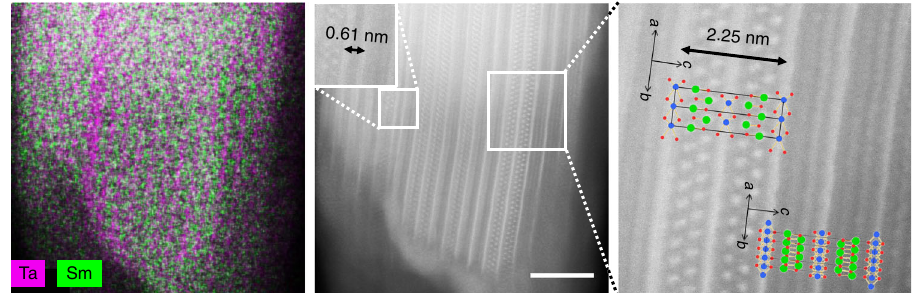
Fig. 4 Microscopy characterization of the (SmS)(TaS 2 ). STEM-EDS and HAADF-STEM images of (SmS)(TaS 2 ) synthesized by ball milling and annealing of SmS and TaS 2 mixture. A broad pink line in the EDS elemental mapping indicates a TaS 2 – TaS 2 double layer that is clearly seen in the HAADF-STEM image (interlayer spacing 0.61 nm). Scale bar, 5